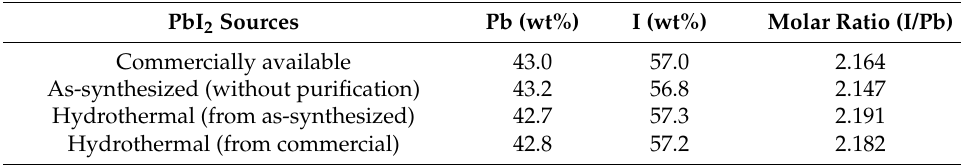
Table 2. X-ray fluorescence spectroscopic analysis of various PbI 2